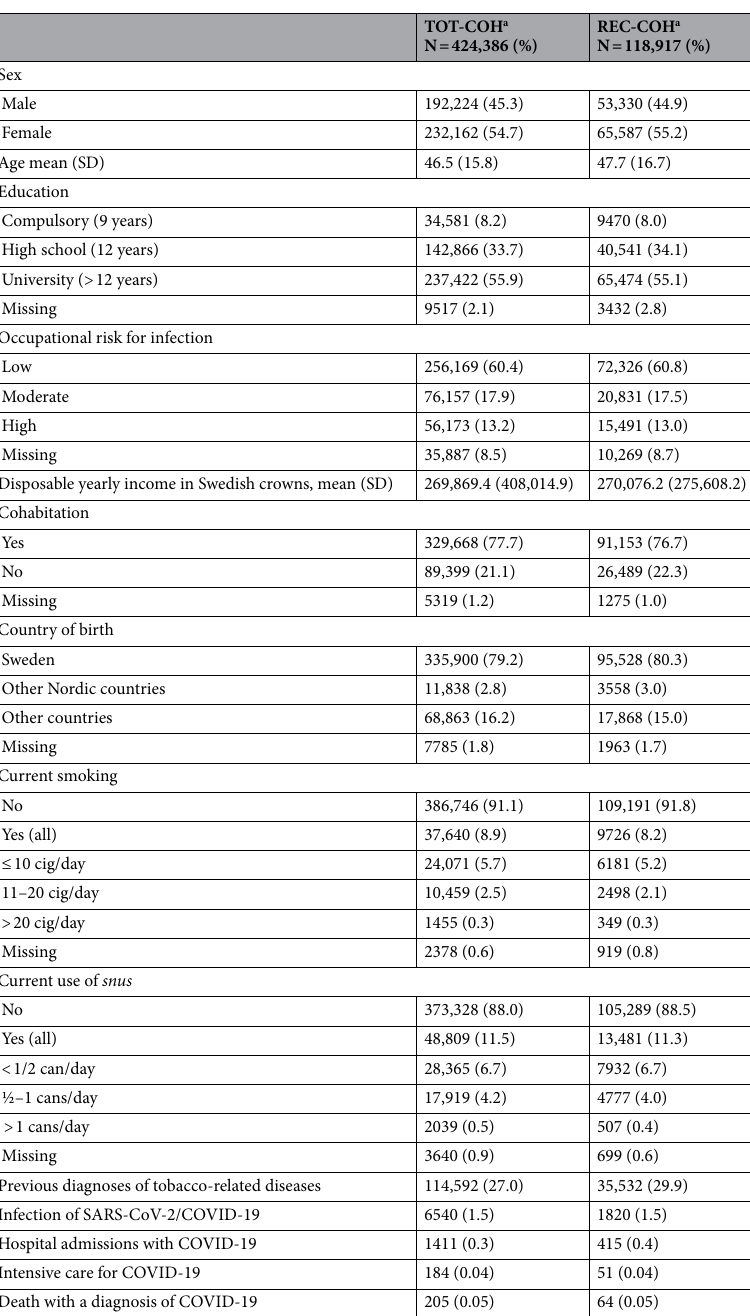
Table 1. Socio-demographic characteristics, tobacco use and incident diagnoses of COVID-19 February 25– October 22, 2020, among clients of the public dental care in Stockholm Region. a TOT-COH = Whole sample REC-COH = recent cohort, i.e., individuals accessing the dental clinics 7 months or less from the onset of the pandemic in Sweden (1st July 2019–31st January